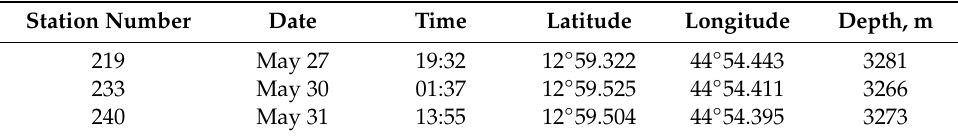
Table 1. Coordinates of TV-grab sampling stations at the Ashadze-2 hydrothermal field, MAR (unpublished in-house report by the PMGE, 2007)